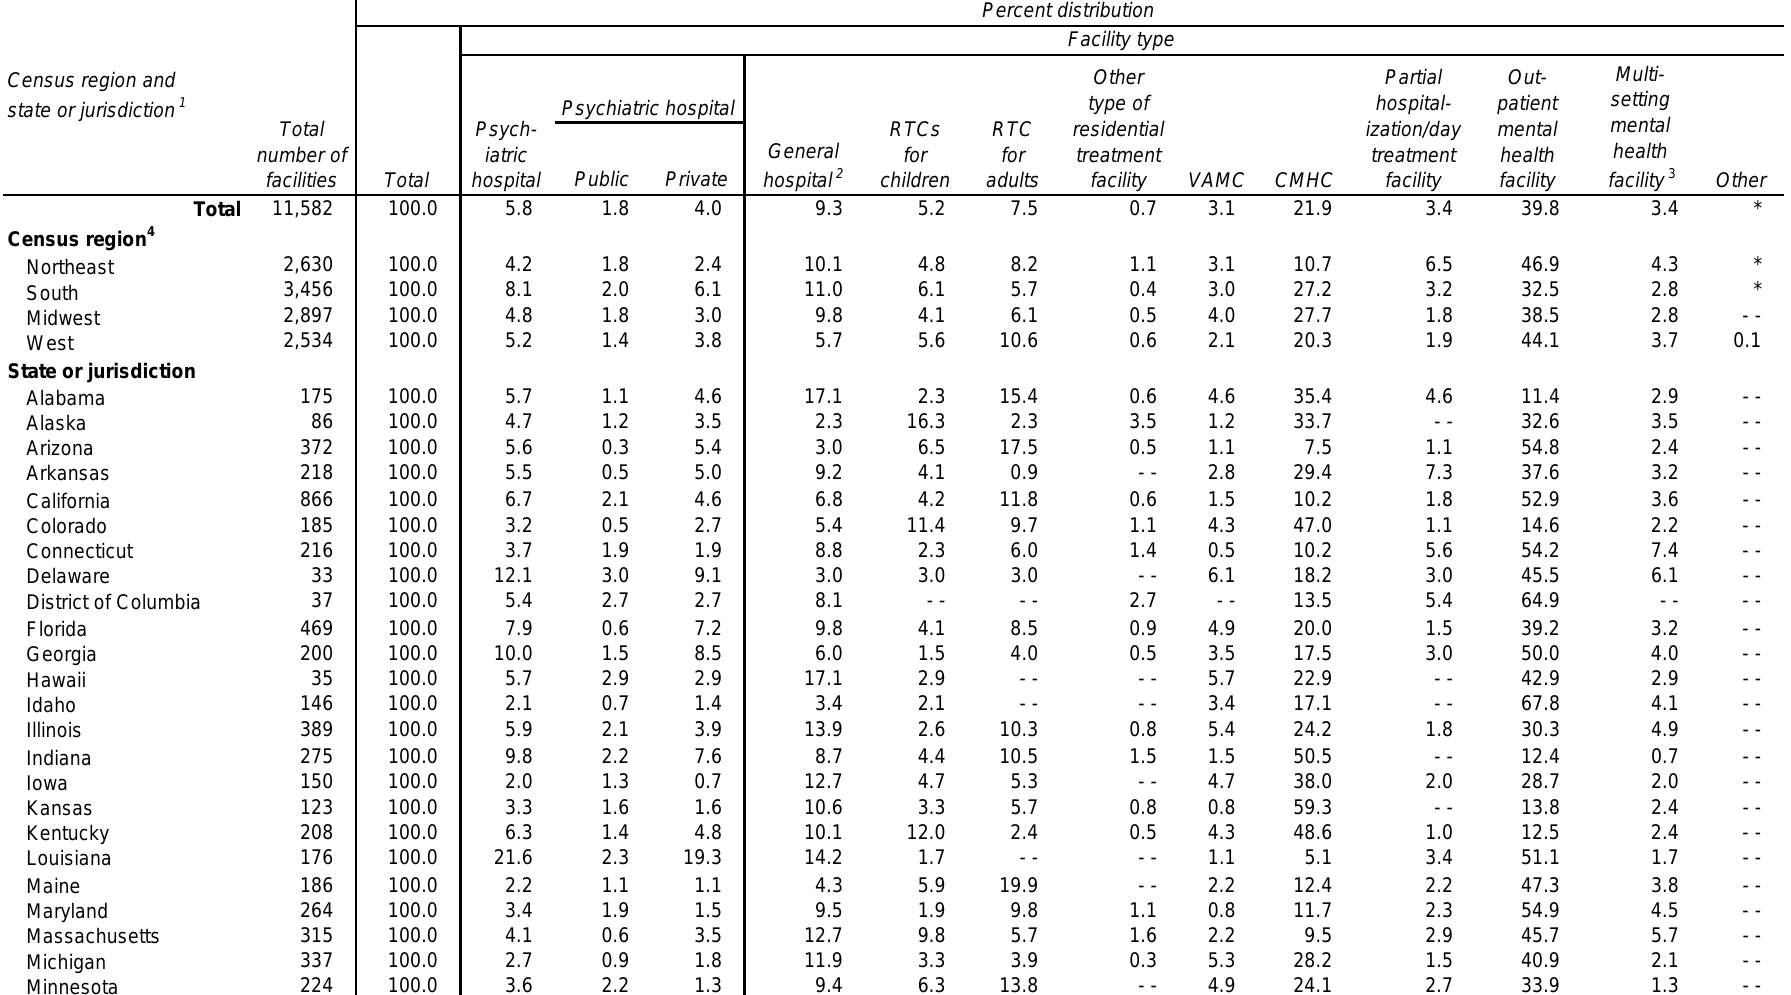
Table 3.1b. Mental health treatment facilities, by facility type, Census region, and state or jurisdiction: Percent, 2017